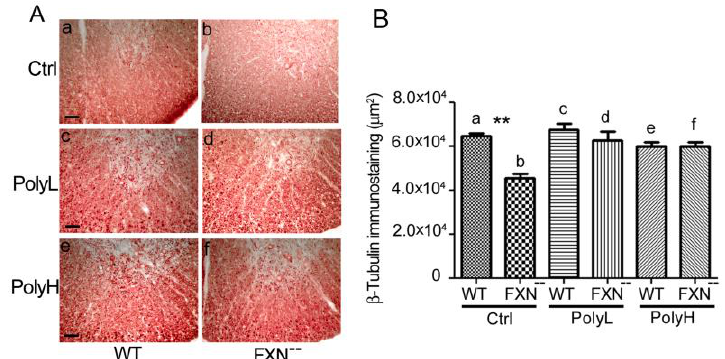
Figure 5. ( A ): β -tubulin expression in the ventral horn of the spinal cord from WT and FXN – mutant mice in control conditions (Ctrl, a,b) or in the presence of low (PolyL: 0.0185 mg / g, c,d) or high (PolyH 0.185 mg / g, e,f) EGCG dosages in the diet. Scale bar: 50 µ m. ( B ): Morphometric analysis of β -tubulin expression in the spinal cord sections shown in ( A ), reported in control conditions (Ctrl) and in conditions of low (PolyL) and high (PolyH) EGCG dietary administration. The significant reduction of β -tubulin expression observed as a consequence of the Frataxin gene mutation (18.55% p = 0.005) (a,b) was e ffi ciently counteracted by EGCG treatment upon either low, PolyL (c,d), or high, PolyH (e,f) conditions. A p -value of 0.001, indicated by **, was considered statistically significant.